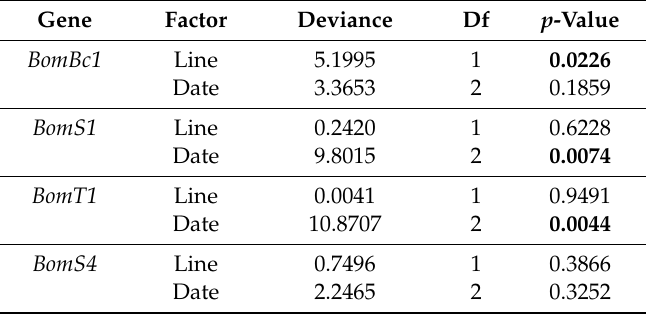
Figure 3. Relationship between Bomanin genes and E. faecalis survival. ( A ) Manhattan plot of genetic variants within the Bomanin cluster on chromosome 2R of the D. melanogaster genome and their association with E. faecalis survival. P -value is plotted as − log 10 P- value. Light grey polygons denote the limits of genes, and the dark grey polygons indicate coding sequences within genes. Color of points denotes location of variant with respect to the closest gene, as per legend. ( B ) Expression of the perfectly linked SNPs 2R_14270226 and 2R_14270228 in uninfected DGRP individuals plotted against survival of the same lines after infection with E. faecalis. Red dots denote the six lines homozygous for the minor allele. In general, these lines display lowered survival after E. faecalis infection (lower left quadrant). Dashed lines indicate means for survival (horizontal line) and uninfected expression (vertical line). ( C ) Survival of Bom-lines versus empty cassette controls after five days of infection with E. faecalis at a dose of OD = 1.5. From left to right, BomBc1, BomS1, BomT1, BomS4 . Table 2. Results of generalized linear models with a binomial distribution and a logit link fitted to survival data for Bom-lines after E. faecalis (EF) infection. Df is degrees of freedom. P -values less than 0.05 are shown in bold.